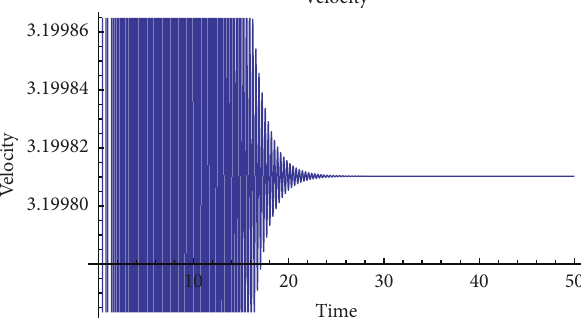
Figure 5: Velocity stabilizes at 3.19981 for 𝜀 = 0.1, 𝐵 = 100, ] = 0